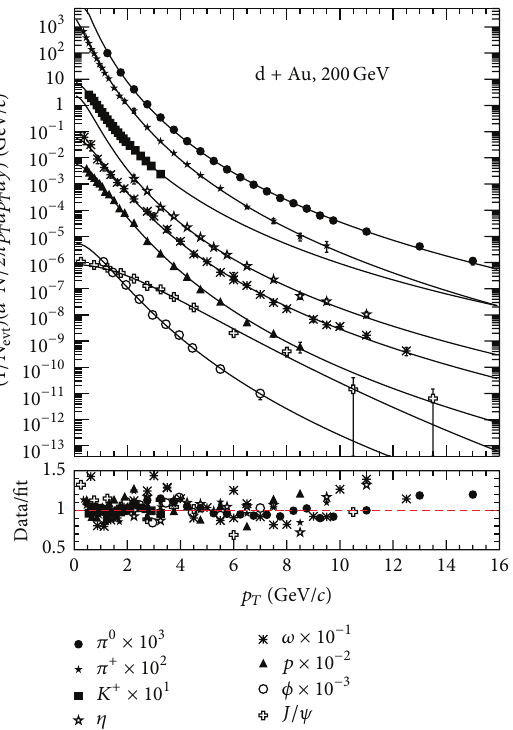
Figure 1: The data are from [10, 11, 27, 39–42] for d + Au at √𝑠 = 200 GeV. The curves are the analytical results with Tsallis 𝑁𝑁 distribution Equation (10). The corresponding fitting parameters and 𝜒 2 /ndf are given in Table 1. For a better visualization both the data and the analytical curves have been scaled by a constant as indicated. The ratios of data/fit are shown at the